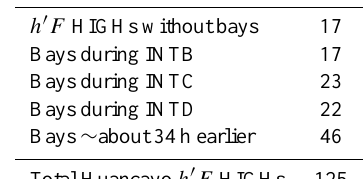
Table 5. Geomagnetic bays associated with Huancayo h 0 F